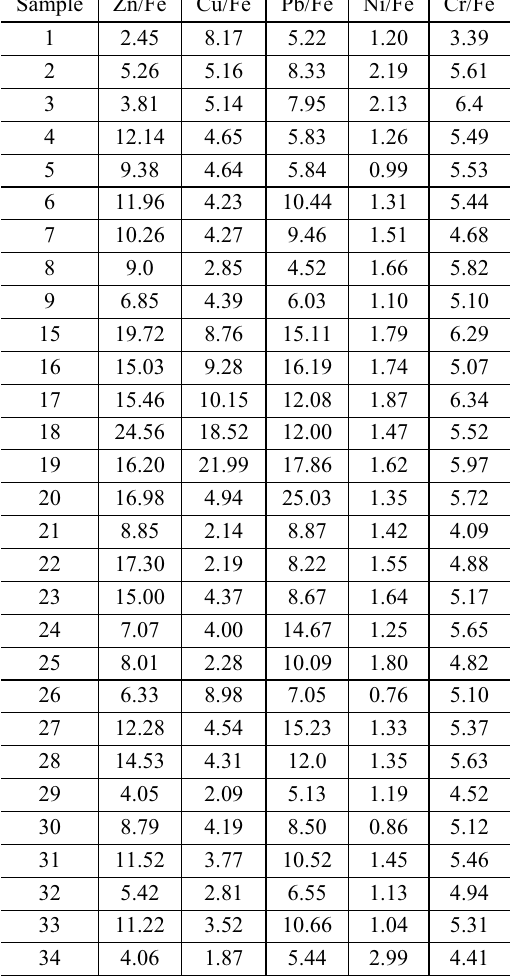
Enrichment factors for selected metals in the urban street sediments ( < 63 mm) from the road around Guanabara Bay. Values normalized by iron and using mean shale as reference (Turekian and Wedepohl